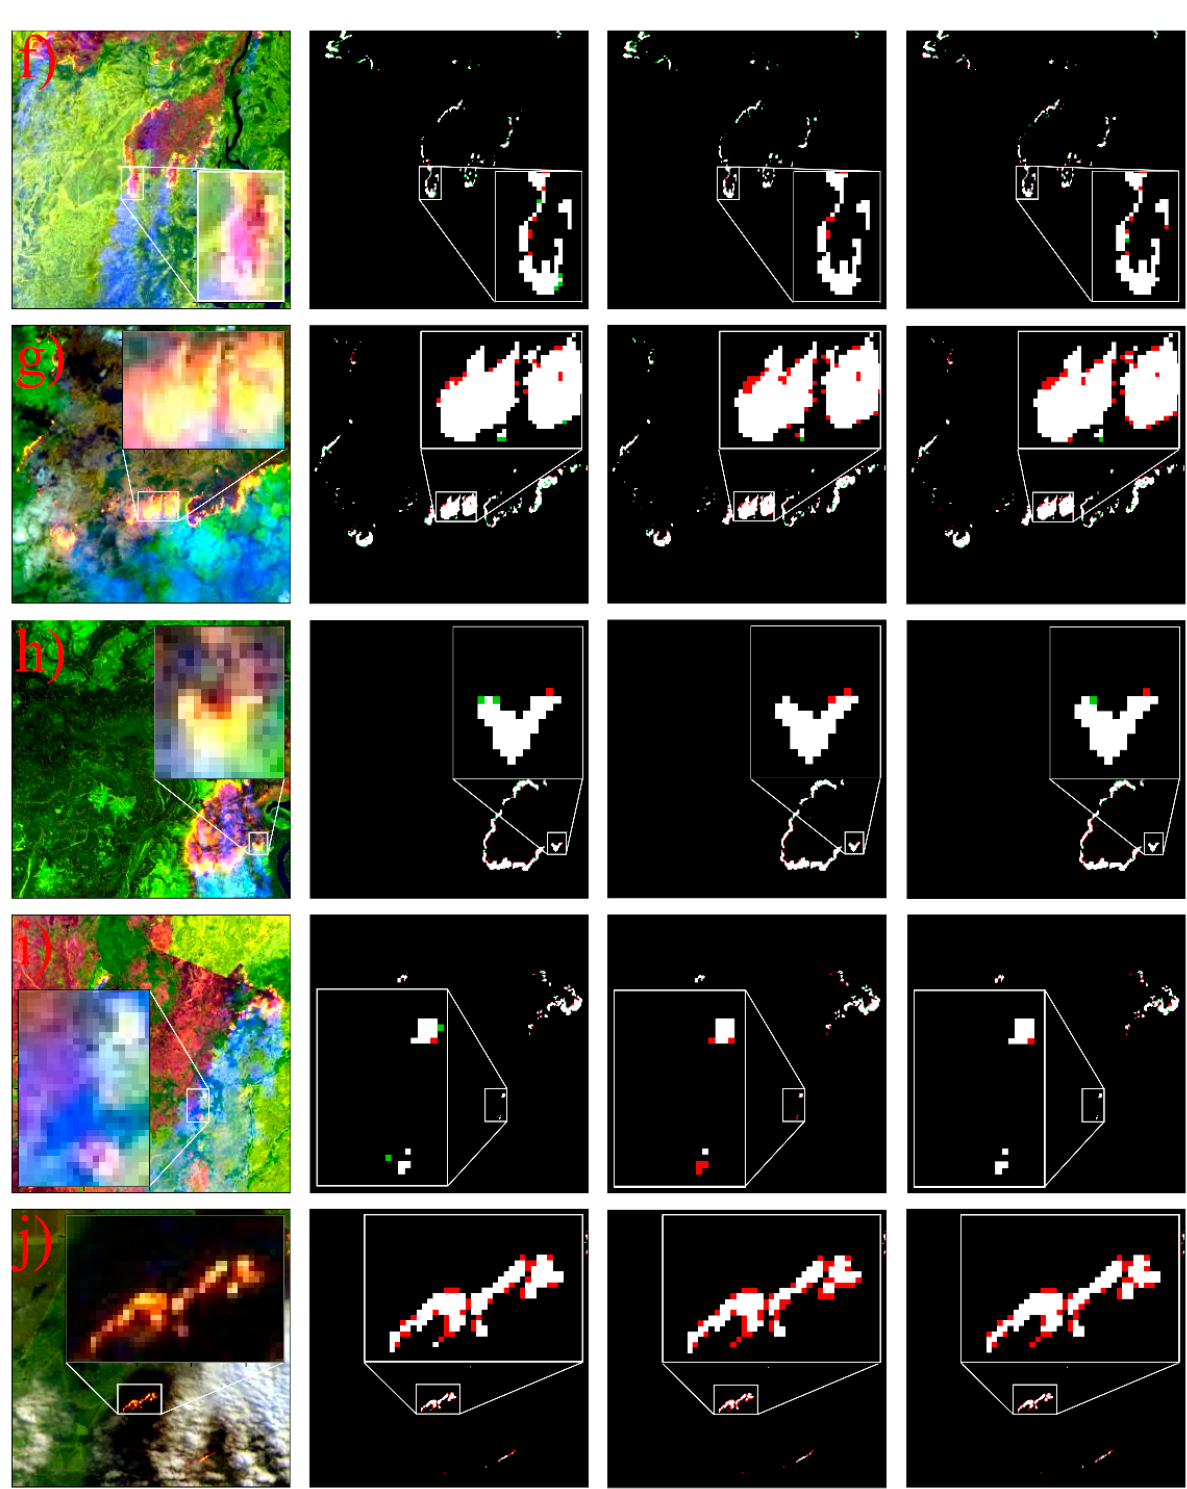
Figure 6. The results of AFD using the three best models of MultiScale-Net for some challenging test samples ( a – j ). White and black pixels indicate the TP and TN, respectively. Red pixels indicate the FN , and green pixels demonstrate FP . False-color: SWIR2 + SWIR1 + Blue.